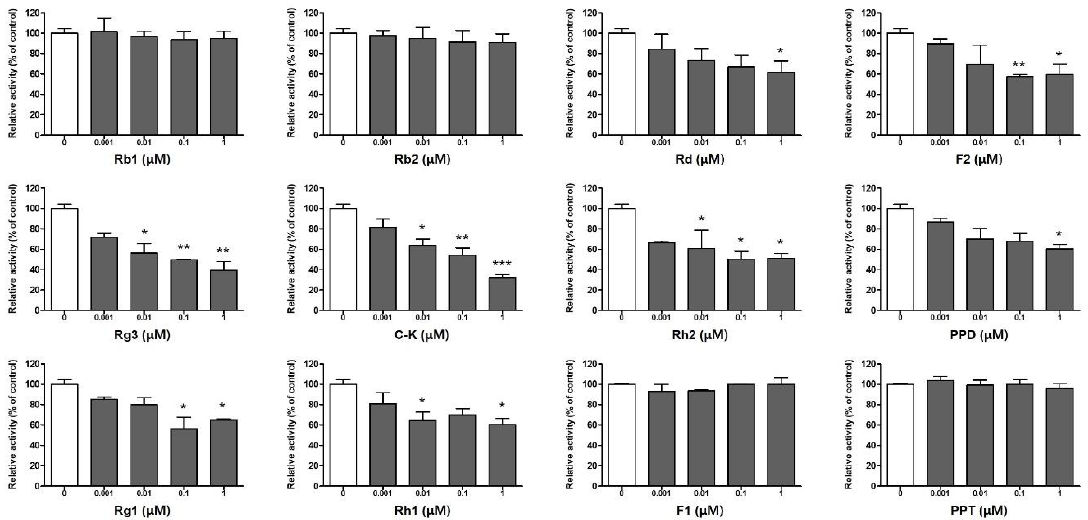
Figure 2. Inhibition of the programmed death receptor-1/programmed death ligand-1 (PD-1/PD-L1) binding interaction by ginsenosides using PD-1/PD-L1 competitive ELISA. Twelve ginsenosides were tested at 0.001, 0.01, 0.1, and 1 μM, and the inhibitory rate of ginsenosides against PD -1/PD-L1 was evaluated using a PD-1/PD-L1 Inhibitor Screening Assay Kit. Data are shown as the means ± SD of three independent experiments. * p < 0.05, ** p < 0.01, and *** p < 0.001, compared with blank (0) group.